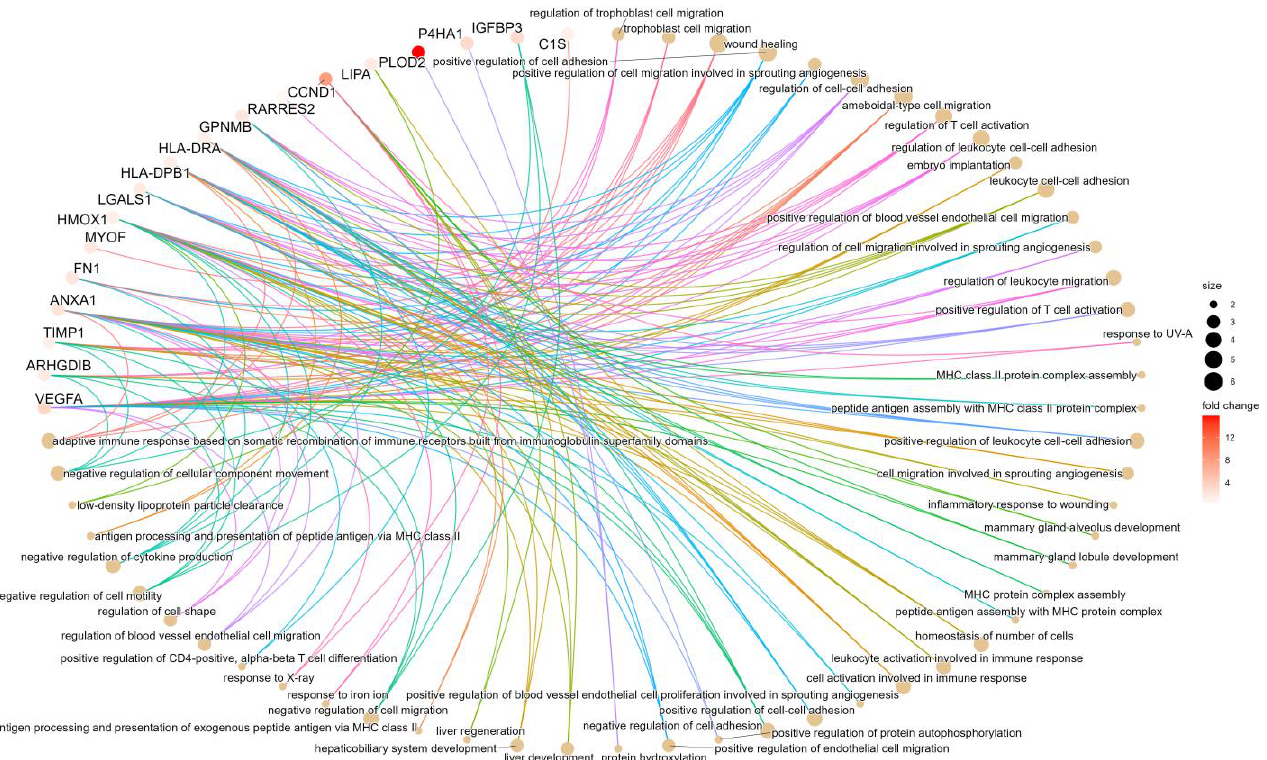
Figure 4. Gene ontology of the top genes. Gene ontology (GO) analysis of the strongest genes which discriminate normal kidney and ccRCC in all investigated cohorts. In the Gene-concept network plot (cnet plot) the linkages of genes and biological concepts are presented as a circular-shaped network. The color of the genes represents the FC values, and the size of the GO terms represents the associated genes. Table 2. Summary table of differential expression analysis of the twenty genes reaching signifi- cance in all cohorts. The nine genes used in the final SVM model building to detect ccRCC are highlighted with bold.